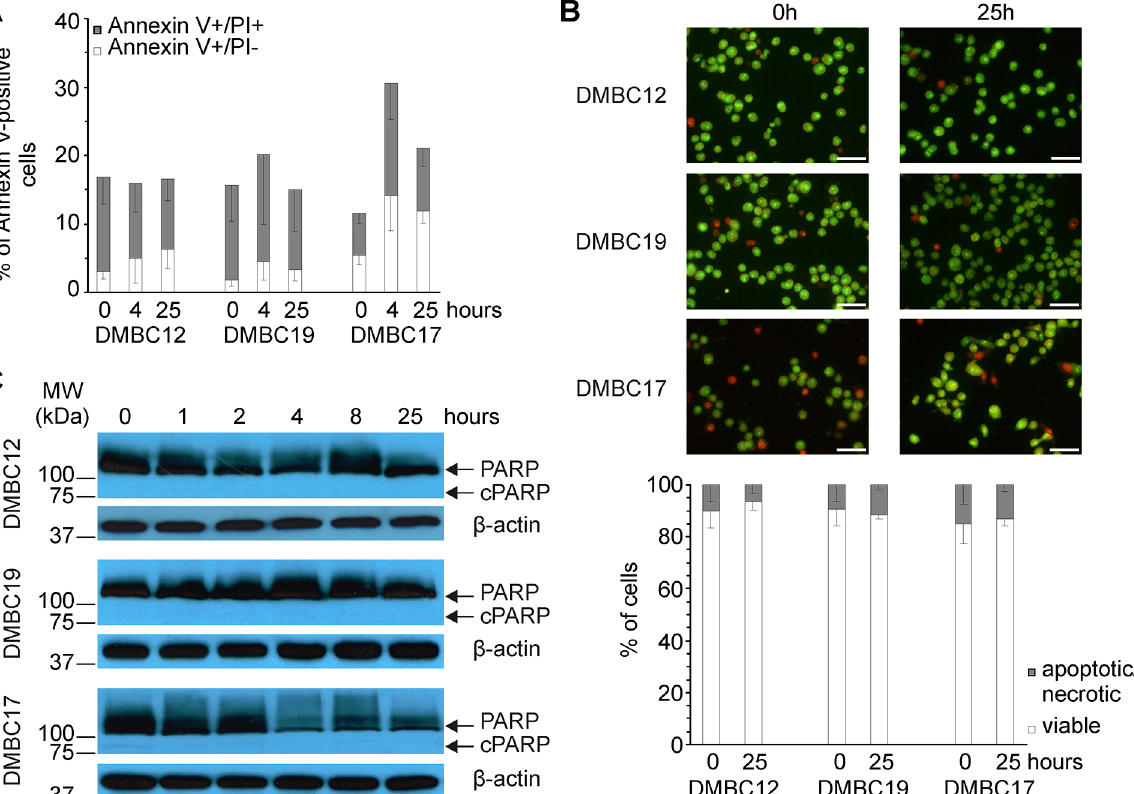
Fig 2. Cell death is not induced in melanoma populations during cell adaptation to serum-containing medium. (A) DMBC12, DMBC19 and DMBC17 populations grown in EGF(+)bFGF(+) medium were dissociated and one day later (0 h) they were exposed to serum-containing medium. Cells were stained with Annexin V/propidium iodide (PI) after 4 h and 25 h, and analyzed by flow cytometry. Data are presented as the means ± SD from three independent experiments. (B) Representative fluorescence microphotographs of melanoma cells stained with acridine orange/ethidium bromide at 0 h and 25 h after medium exchange. Scale bar, 50 μ m. Quantitative analysis of the frequency of apoptotic/necrotic and viable cells was shown below. Data are presented as the means ± SD from three independent experiments. (C) Cell lysates were prepared at indicated time points of exposition to serum-containing medium and PARP was immunoblotted (n = 3). Upper and lower arrows indicate full-length and cleaved PARP (cPARP), respectively. Localization and molecular weight (MW) of marker bands are indicated. β -actin was used as a loading